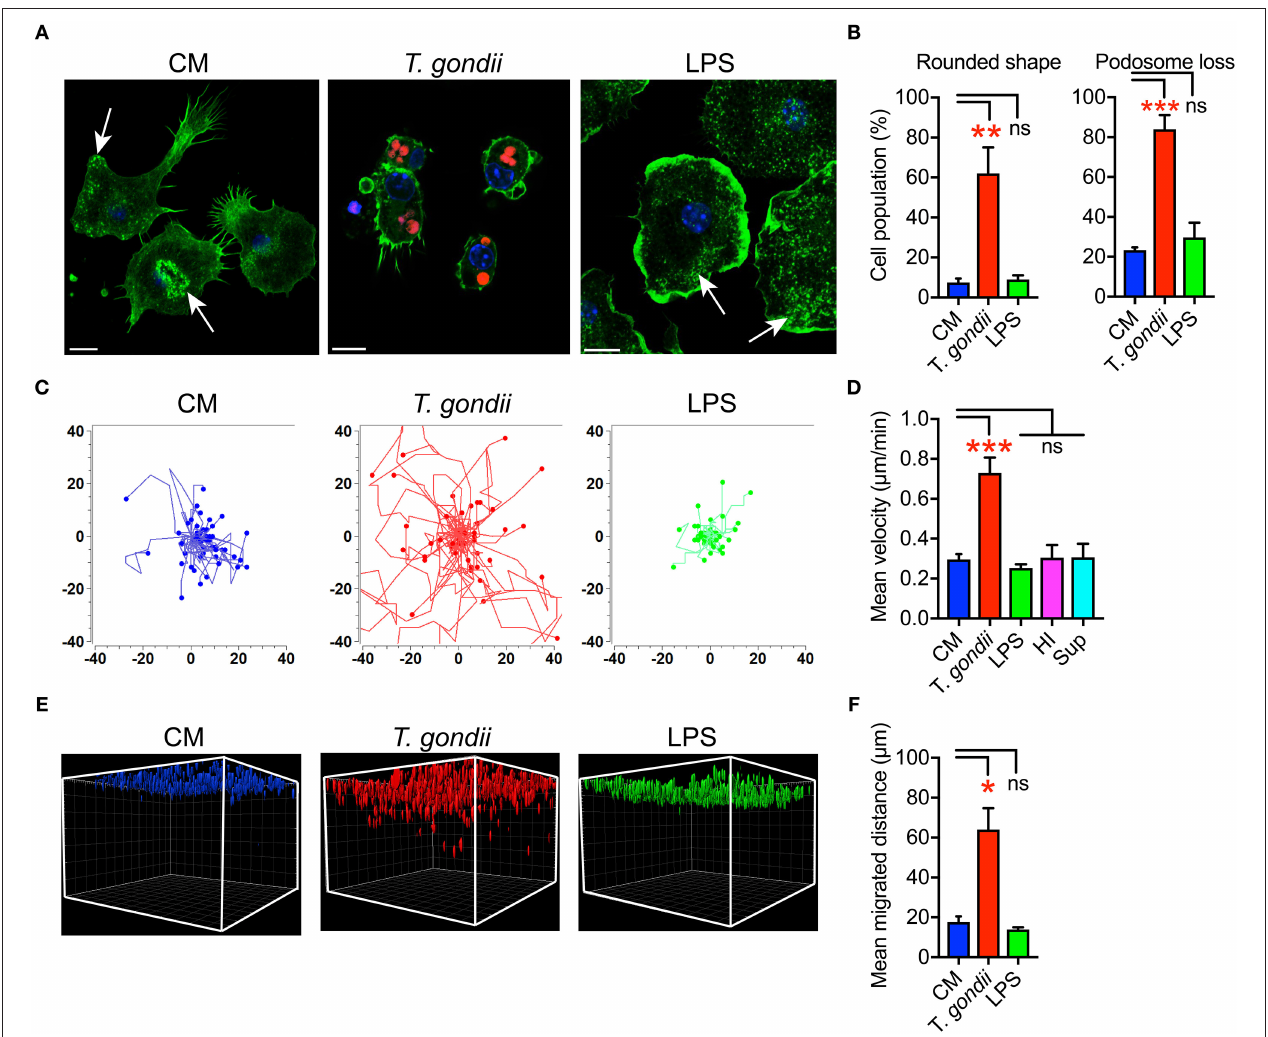
FIGURE 1 | Morphological changes and hypermigration of Toxoplasma- challenged primary cortical microglia. (A) Representative micrographs of primary microglia stained with Alexa Fluor 488 Phalloidin to detect F-actin, as indicated under Materials and Methods. Primary murine microglia were incubated with freshly egressed RFP-expressing T. gondii tachyzoites (PRU-RFP, MOI 3), treated with LPS (100ng/ml) or maintained in complete medium (CM), for 4h. Arrows indicate F-actin condensation in podosome structures. Scale bar = 10 µ m. (B) Percentage of cells that exhibited rounded cell shape and podosome loss, respectively, related to the total cell population analyzed for each condition from a total of 50–100 cells from 3 independent experiments. (C) Representative motility plots of microglia incubated with PTG tachyzoites for 4h, complete medium (CM) and with LPS (100ng/ml). (D) Mean velocities of microglia incubated with complete medium CM), PTG tachyzoites, heat-inactivated tachyzoites (HI), supernatant from T. gondii- infected microglia (Sup) are analyzed from 4 independent experiments. (E) Migration of microglia in matrix as indicated under Materials and Methods. One representative 3D reconstruction assembly of z-stacks is shown. Colored structures indicate the localization of individual microglia (DAPI) at indicated conditions. (F) Mean migrated distances by microglia under same condition as in E . Data represent compiled analysis of 500 randomly chosen cells from 2 independent experiments in duplicate. For (B,D,F) , bar graphs represent mean + SEM. Statistical significance